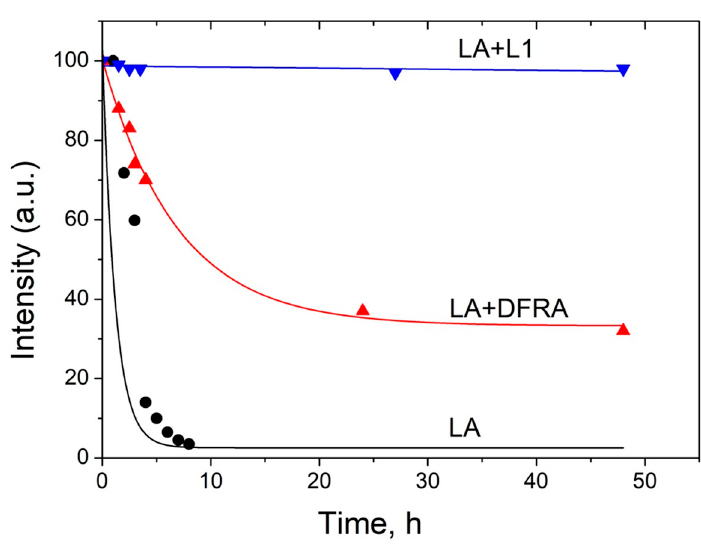
Figure 5. Kinetics of the initiation reaction phase of the linoleic acid (LA, 3.5 mM) peroxidation induced by FeSO 4 (0.1 mM) and H 2 O 2 (0.5 M) in the presence and absence of deferasirox (DFRA, 2 mM) and deferiprone (L1, 2 mM). The studies were carried out at room temperature, in buffer solution (0.1 M) of pH 7.4. The graphs were plotted using the decay of the integral intensity signal of the LA protons at 2.7 ppm. ( a.u., arbitrary units).